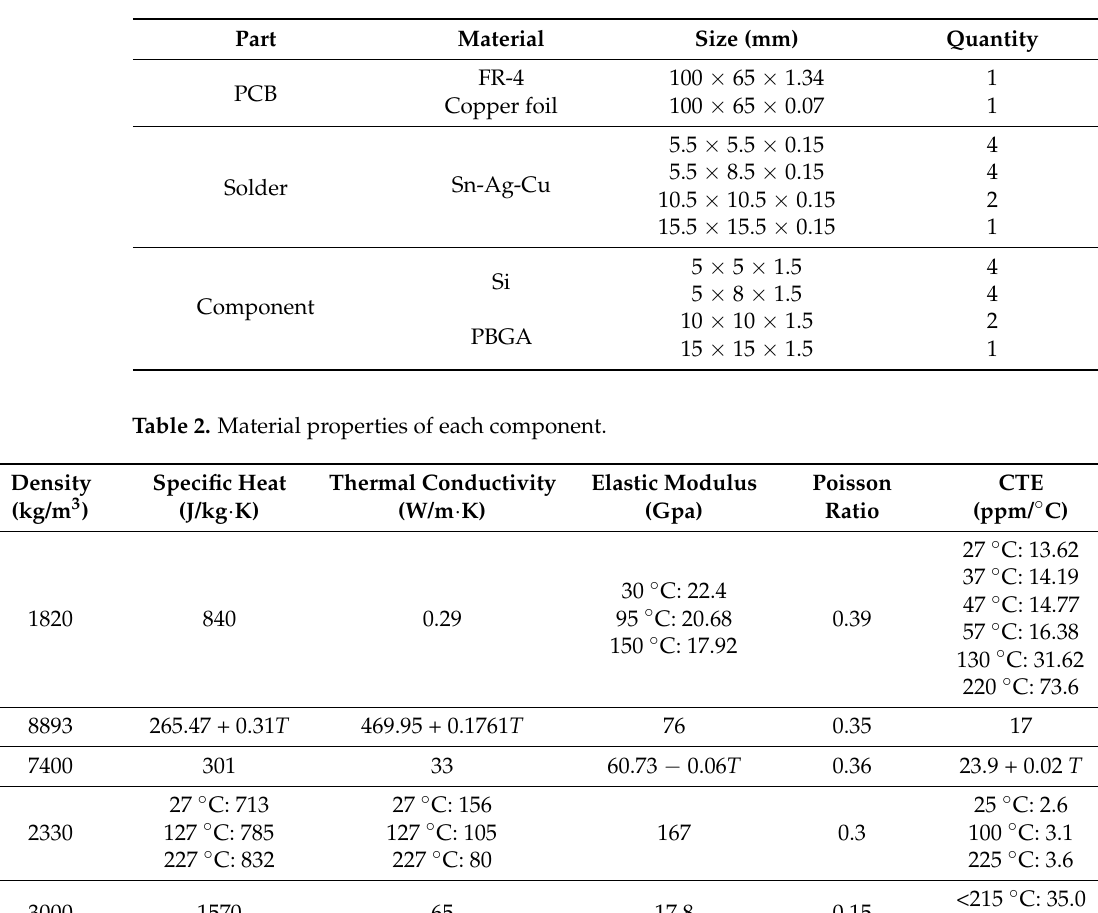
Table 1. Geometric dimensions of the PCB assembly.